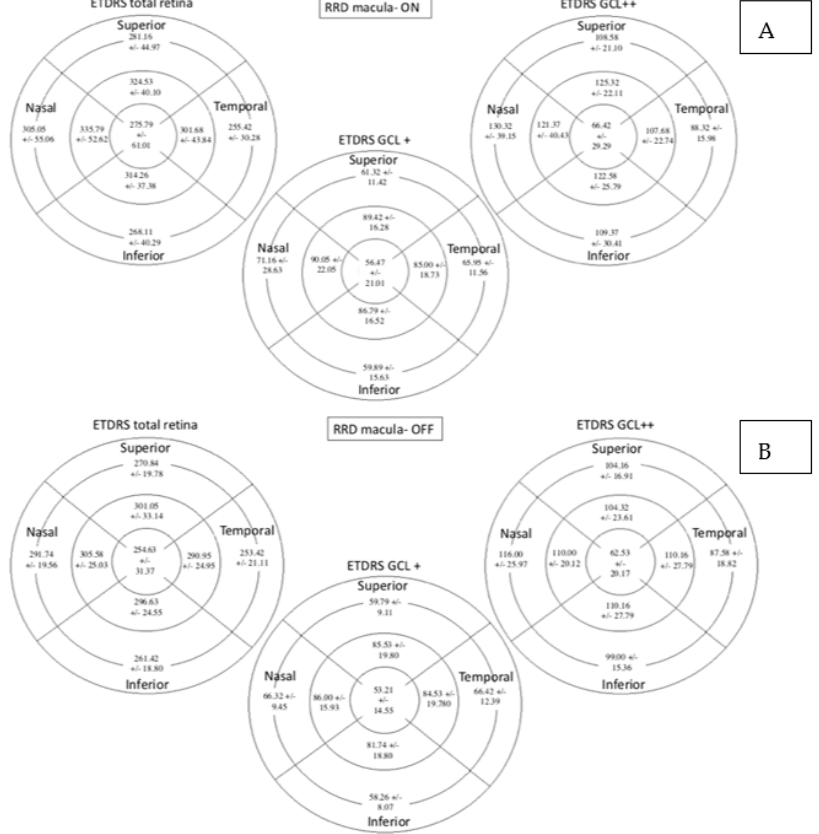
Figure 6. Retinal thickness measured by SS-OCT with the total retina protocol, GCL+ protocol and GCL++ protocol expressed in microns. Figure ( A ) represents macula-On subgroup and Figure ( B ) represents macula-Off. Mean +/ − standard deviation is included in every sector. SS-OCT: swept source optical coherence tomography; ETDRS: Early Treatment Diabetic Retinopathy Study; GCL: Ganglion cell layer.